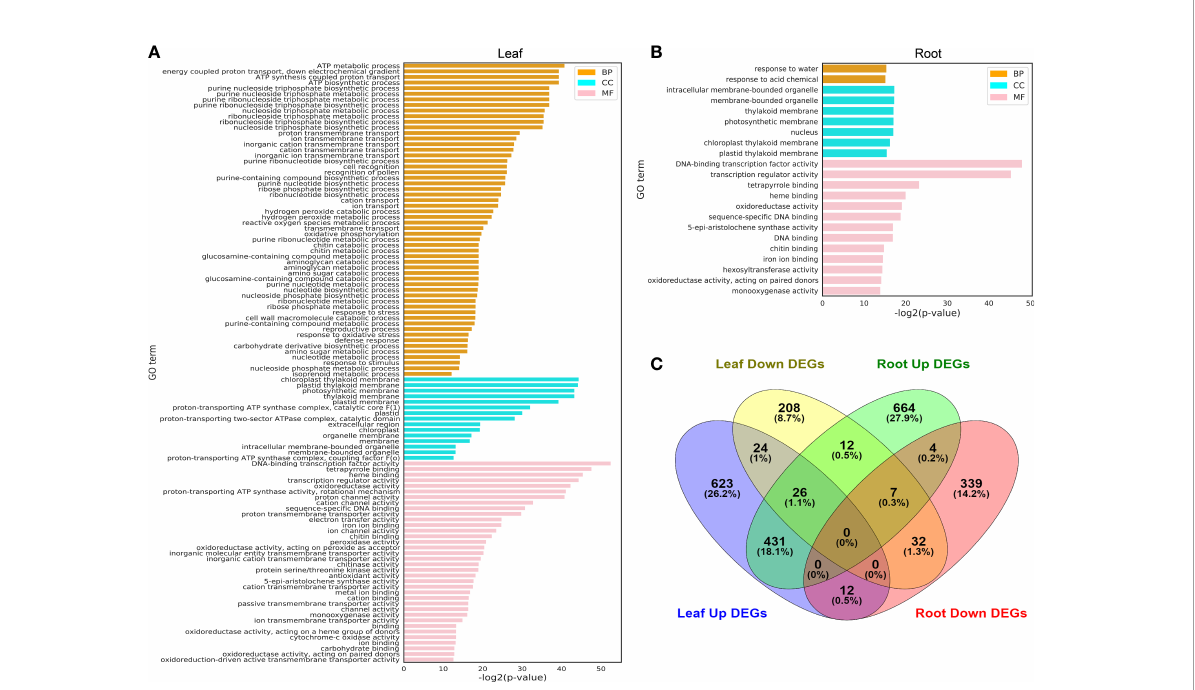
FIGURE 4 GO terms of leaf and root DEGs under hydrogen peroxide stress. (A) GO terms identi fi ed from the different treatment time points of leaf DEGs (FDR < 0.01). (B) : GO terms identi fi ed from the different treatment time points of root DEGs (FDR < 0.01). (C) : Venn diagrams of upregulated and downregulated DEGs identi fi ed in the leaf and root tissues. The full lists of DEGs and GO terms from the enrichment analysis are shown in Supplementary Tables S4,